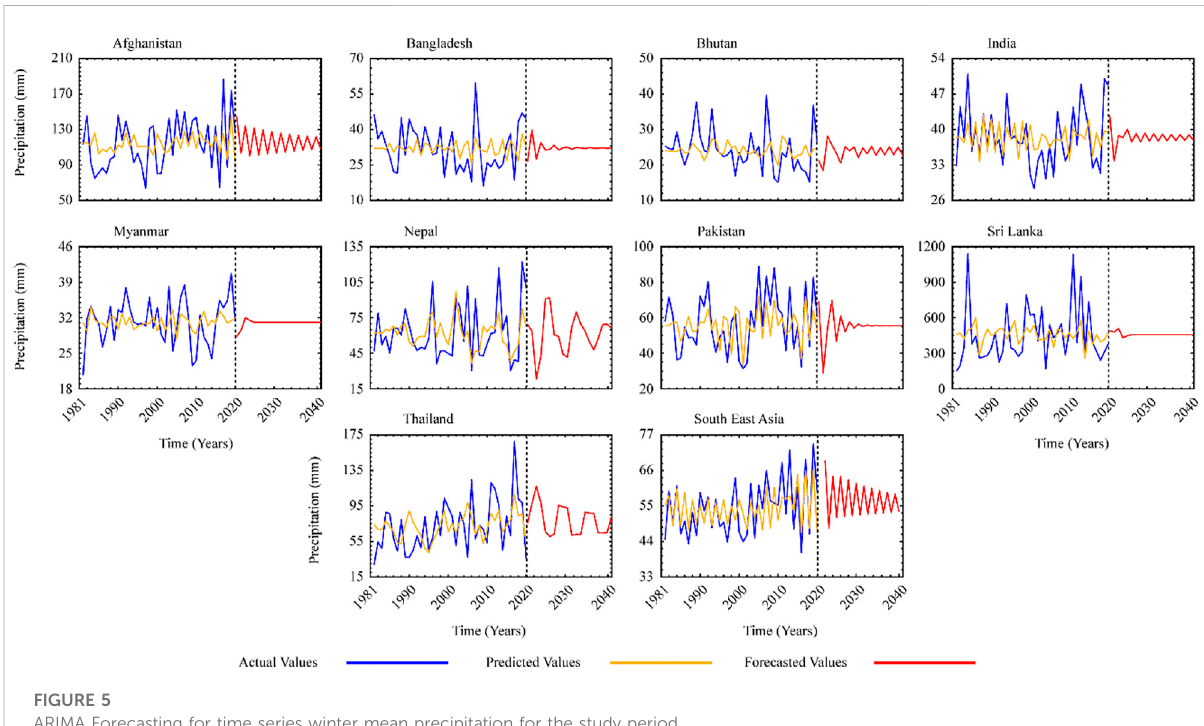
FIGURE 5 ARIMA Forecasting for time series winter mean precipitation for the study period.